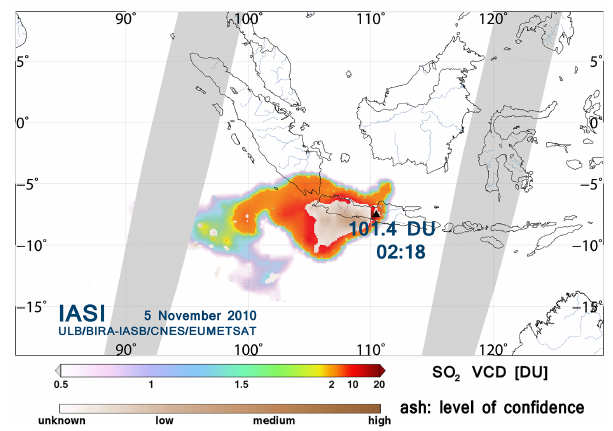
Fig. 20. Ash image superimposed over the SO 2 image from IASI-A during Merapi’s eruption (5 November 2010).